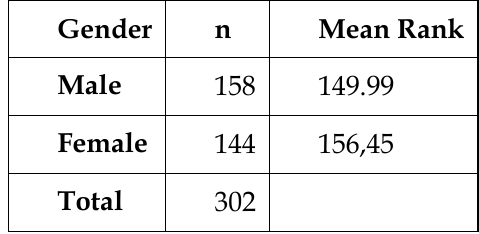
Table 23. Trust towards the health centre and gender. Mann-Whitney U mean rank.